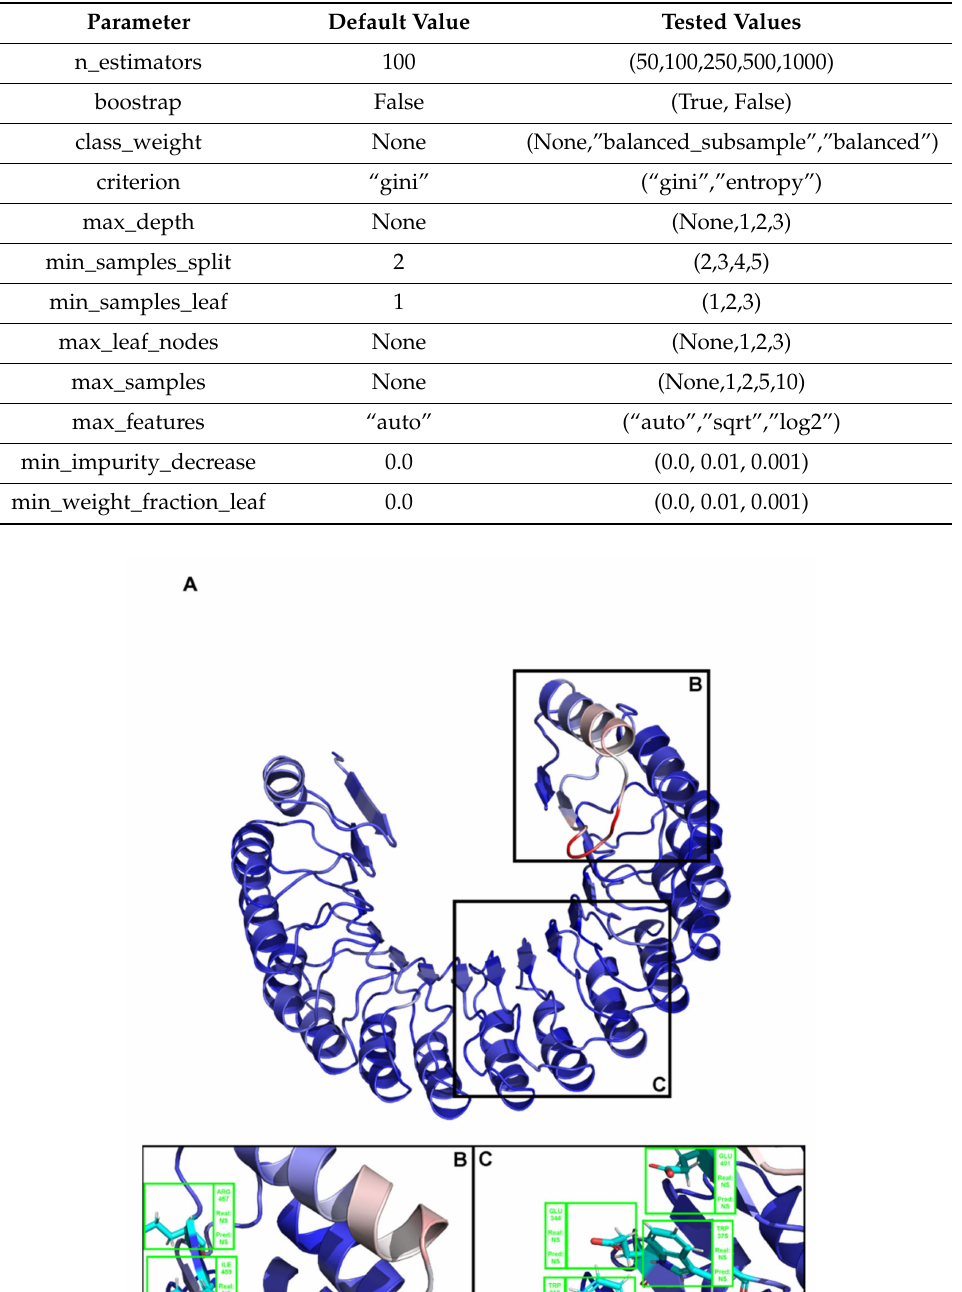
Table A6. Extreme randomized trees parameters tested in the Grid Search.